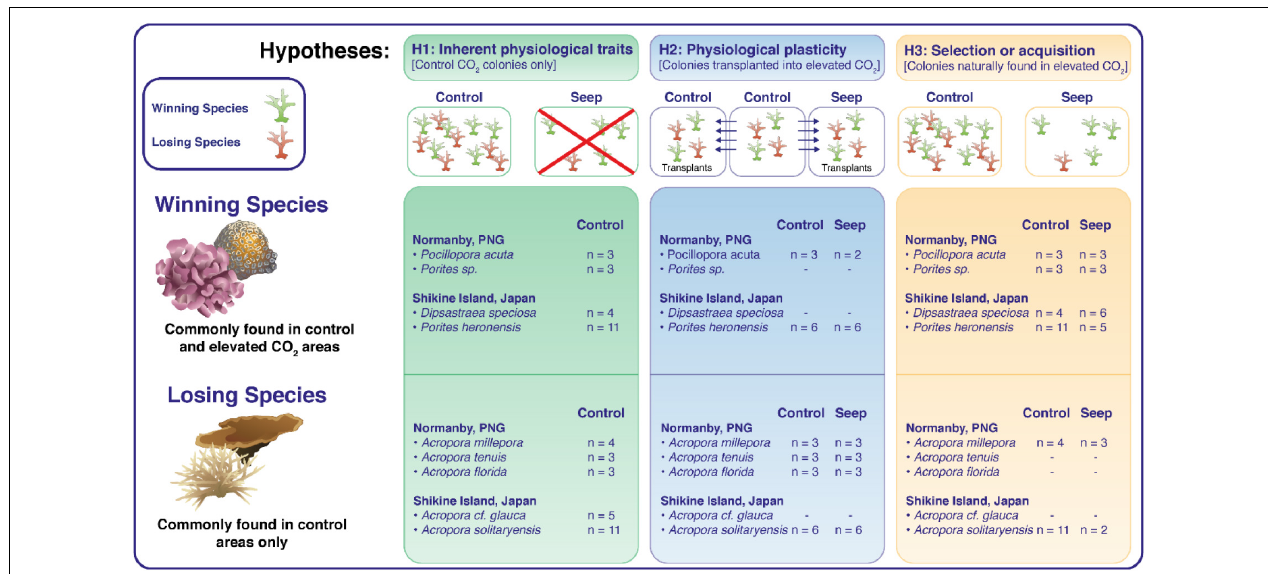
FIGURE 1 | Physiological traits (Protein per surface, surface area-specific ETSA and biomass-specific ETSA) of coral specimens belonging to winning species and losing species were used to test three hypotheses. (1) Inherent physiological traits of coral species resistant to ocean acidification: Physiological traits of corals in control areas; (2) Physiological plasticity as an acclimation response to ocean acidification: Physiological traits of corals transplanted from control areas into control and elevated p CO 2 areas (seep); (3) Selection or acquisition of resistance to ocean acidification: Physiological traits of corals found naturally in both elevated p CO 2 (seep) and control areas ( n indicates the number of coral specimens used for each species and each CO 2